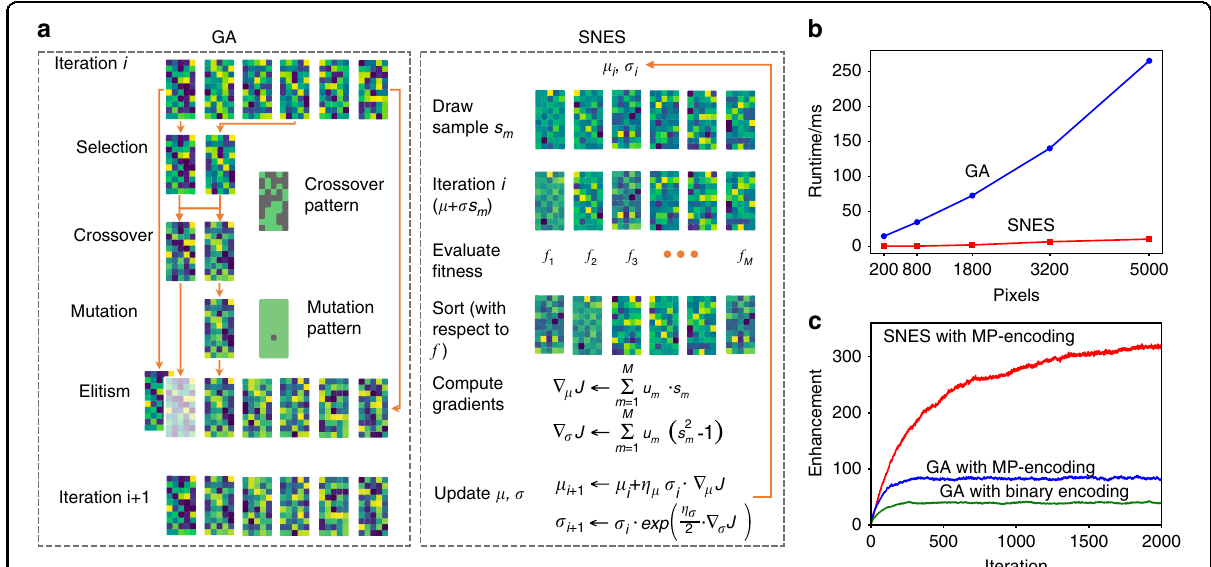
Fig. 2 Comparison of GA and SNES by numerical simulation. a Diagrams of GA (left) and SNES (right). b Computation times of the two algorithms. c Enhancement of the light intensity at the target point. MP,